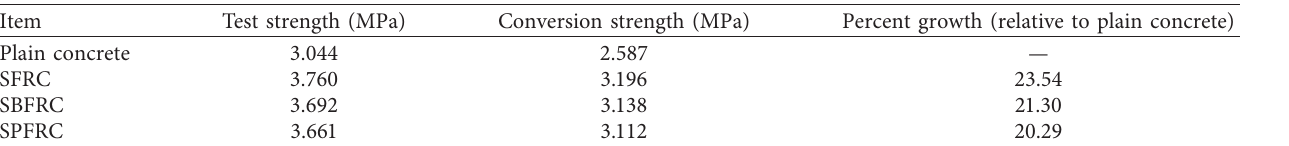
Table 3: Test results of flexural